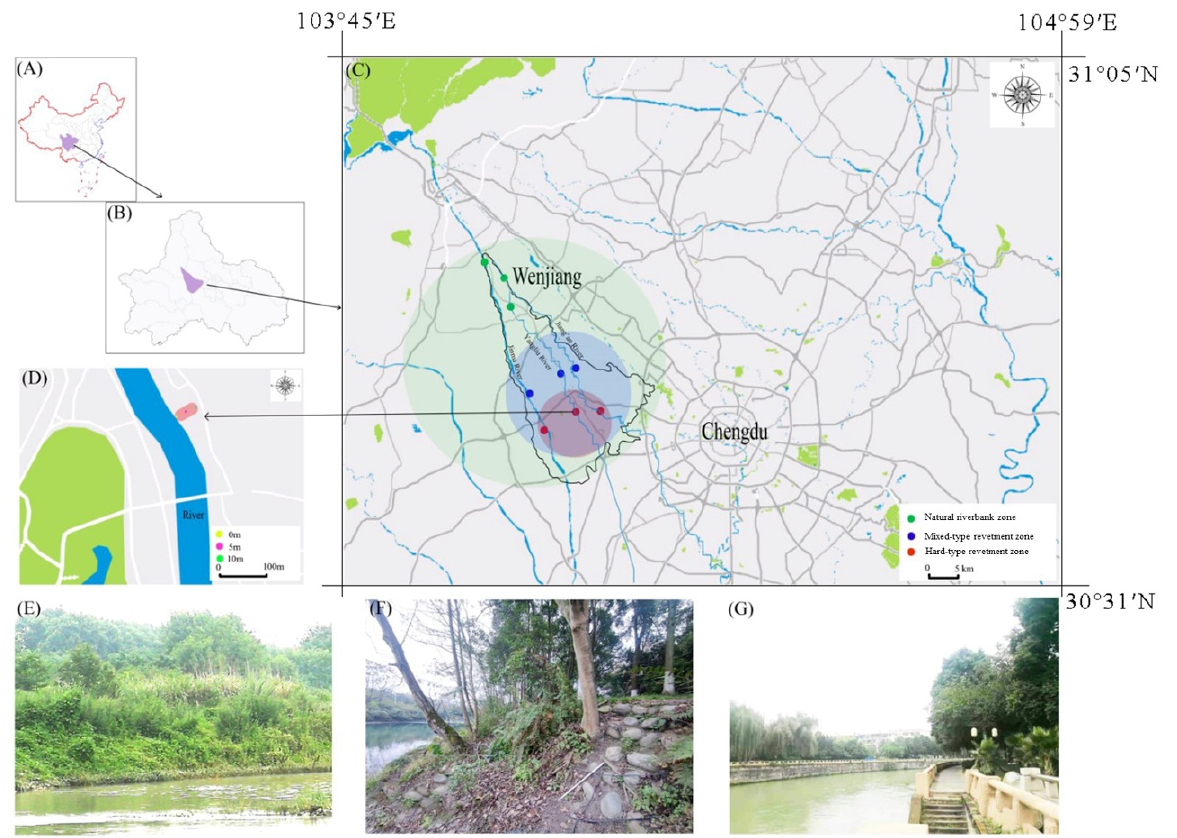
Figure 1. Distribution of the sampling plots along three main rivers in Wenjiang district. Sichuan Province is located in the southwest of China ( A ); Wenjiang is in the middle of Chengdu ( B ). Different urban–rural habitats are marked with round color blocks ( C ). Green color block represents a rural habitat, blue color block represents a suburban habitat, red color block represents an urban habitat ( C ). All sampling plots are marked with colored dots ( C , D ). Green dots represent a natural riverbank zone in a rural habitat, blue dots represent a mixed-type revetment zone in a suburban habitat, and red dots represent a hard-type revetment zone in an urban habitat ( C ). Yellow dots, purple dots, and black dots represent the sampling locations with different distances from the edge of the riverbank in each type of revetment zone ( D ). ( E ) Natural riverbank zone (NR); ( F ) mixed-type revetment zone (MR); ( G ) hard-type revetment zone (HR). Image ( C ) is exported from Planning Cloud (www.guihuayun. com, accessed on 27 October